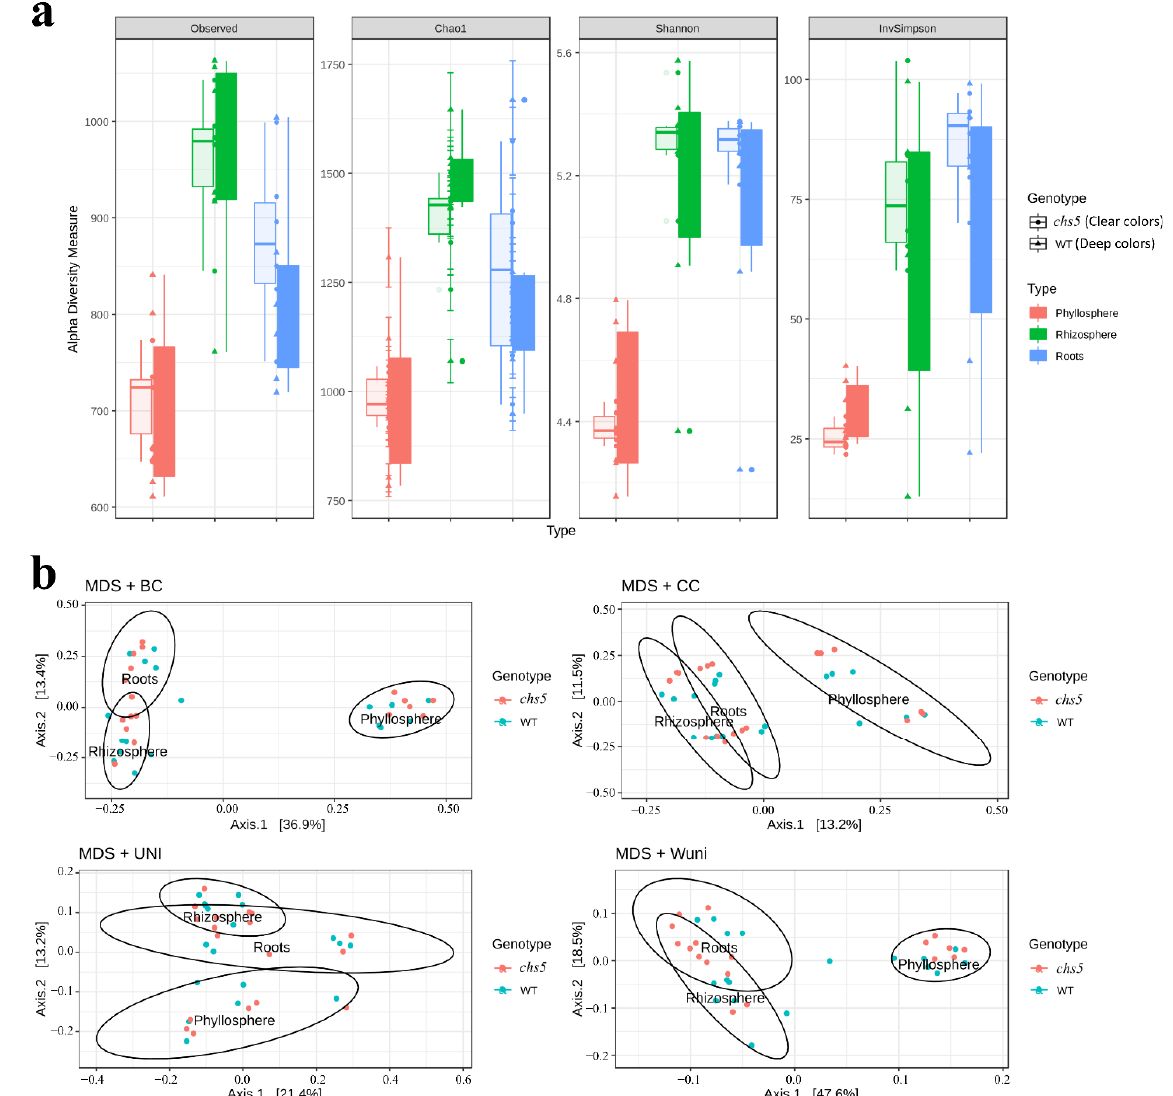
Figure 4. α - and β -diversity analysis of bacterial community structures of Arabidopsis wild type (WT) and chs5 mutant grown in STC at the rosette stage. Two biological replicates including three technical replicates were considered in each case. ( a ) α -diversity of wild-type and chs5 microbiota in the phyllosphere, rhizosphere, and roots. Four different α -diversity indexes were used to study the global richness and diversity (see the Materials and Methods section): the richness was evaluated using the “observed” or the Chao1 indexes; the evenness (representing the phylogenetic diversity)54was expressed with the Shannon and the inverse Simpson indexes. When grown in STC at the rosette stage, the richness and evenness are higher in the rhizosphere and roots than in the phyllosphere (ANOVA, p -value < 0.001). No significant difference was observed between WT and chs5 (ANOVA, p -value = 0.439, 0.962, 0.278, 0.234 for the observed, Chao1, Shannon, and InvSimpson indexes, respectively). Clear colors: chs5 ; deep color: wild type. ( b ) β -diversity analysis illustrated by multidimensional scaling (MDS/PCoA). Four β -diversity indexes were used to compare the different samples (see Materials and Methods). The Bray–Curtis and the Jaccard indexes allowed us to compare the composition of the communities, whereas the Unifrac or weighted Unifrac allowed us to compare the phylogenetic diversity [55]. MDS/PCoA based on these indexes revealed that, when grown in STC, the community composition and the phylogenetic diversity were distinct in the three plant compartments. The ellipses were drawn at the 95% confidence interval of standard error and the mean value of the